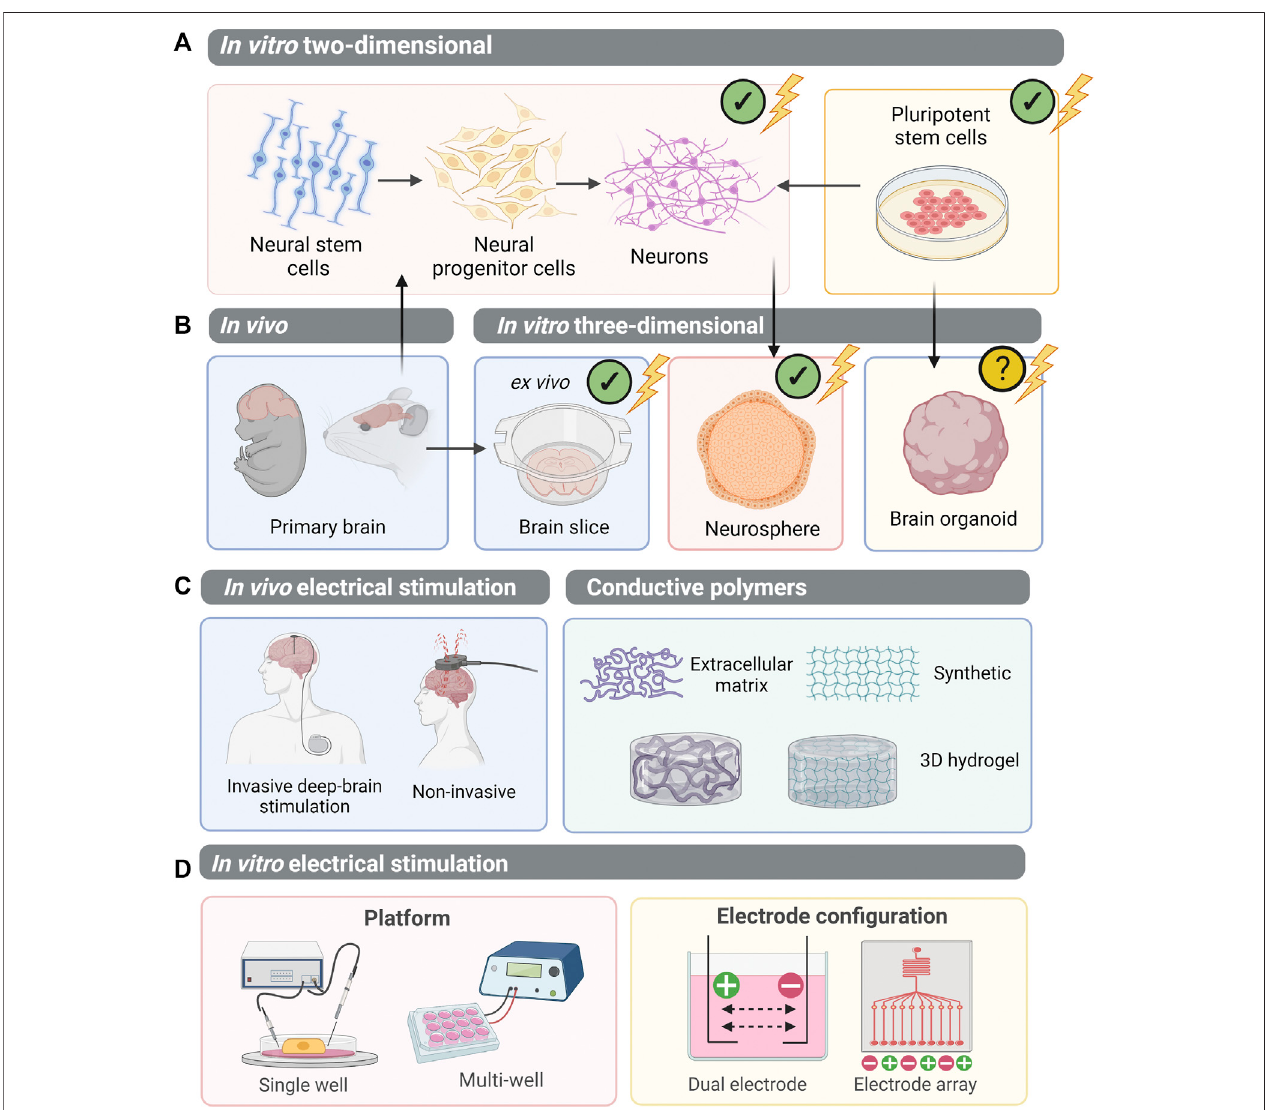
FIGURE4| ElectricalstimulationofCNScells:movingtowardsPSC-derivedorganoids. (A) Multipotentneuralstemcellscanbeisolatedfromtheprimarybrainand differentiated to neural progenitor cells and neurons. Alternatively, pluripotent stem cells can be differentiated into a neural lineage. Electrical stimulation studies have been undertaken on these two-dimensional systems. (B) Three-dimensional systems which have been employed to study electrical stimulation in vitro include primary brain slices (an ex vivo model of the CNS), and neurosphere aggregates derived from neural progenitor cells. However, the study of electrical stimulation on pluripotent stem cell-derived brain organoids remains unexplored. (C) In vivo , electrical stimulation of the brain is performed on patients either using invasive methods, whereby electrodes directly contact brain regions, or non-invasively. To mimic in vivo brain stimulation in in vitro models of the brain, conductive polymers within 3D hydrogels have been utilised. (D) However, to best apply electrical stimulation to PSC-derived CNS organoids, suitable delivery platforms must be established. A single wellsystemallowscontrolleddeliveryofelectricalstimulation,whilstamulti-wellplatesystemishigher-throughputtoallow insitu electricalstimulationofcells.Electrodes can be con fi gured in arrays, or pairs, generating electrical fi elds between each cathode (+) and anode ( − ). ( ✔ ), electrical stimulation experimentation performed; (?), not yet explored.